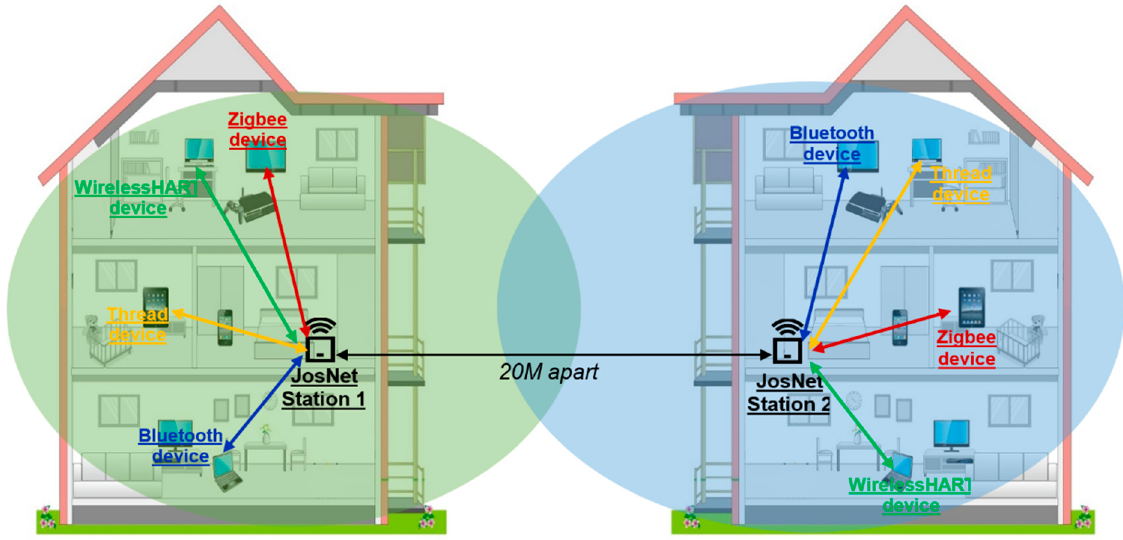
Figure 11. Structural representation of multiconnected buildings using JosNet.